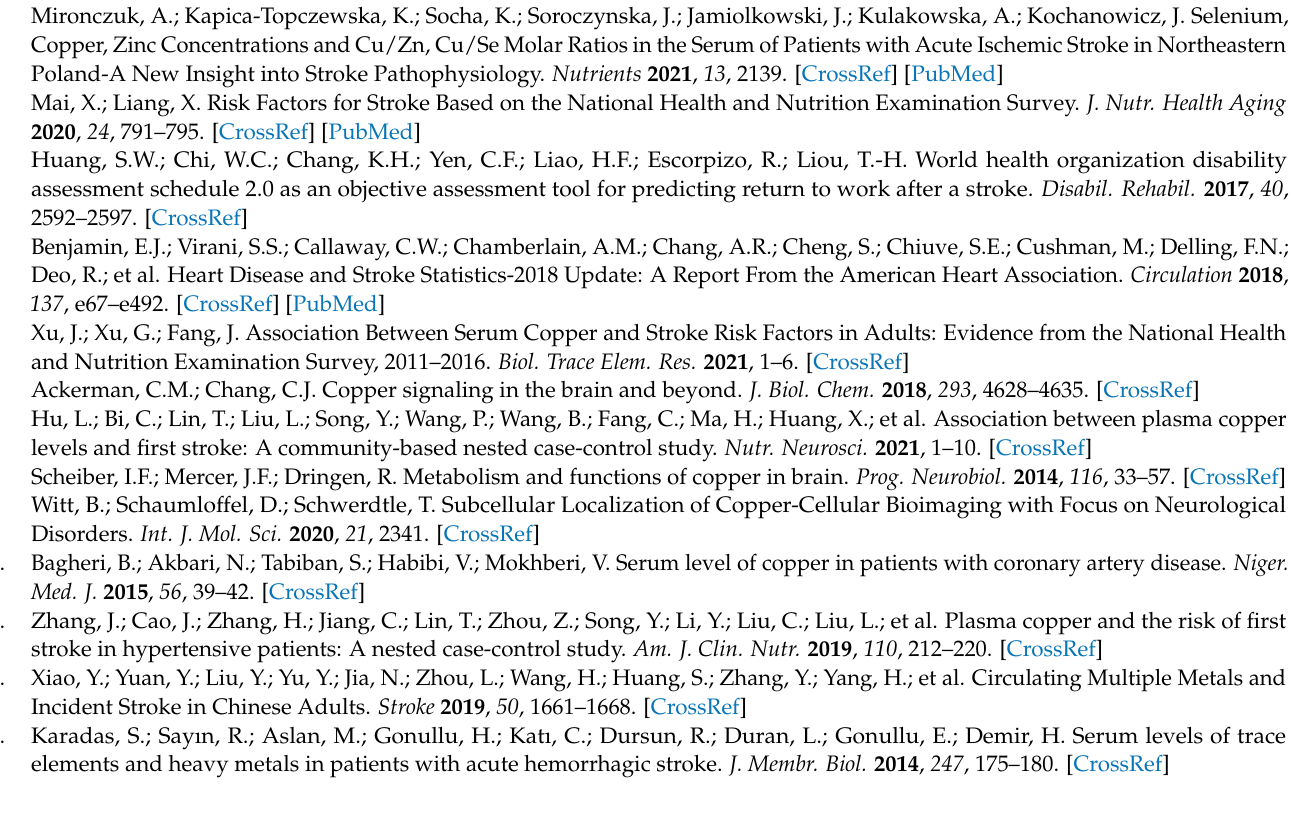
matching, Table S1: Association between copper intake and stroke as categorized by sex, Table S2: Association between copper intake and stroke as categorized by age, Table S3: Association between copper intake and stroke as categorized by hypertension, Table S4: Association between copper intake and stroke as categorized by smoking, Table S5: Association between copper intake and stroke as categorized by